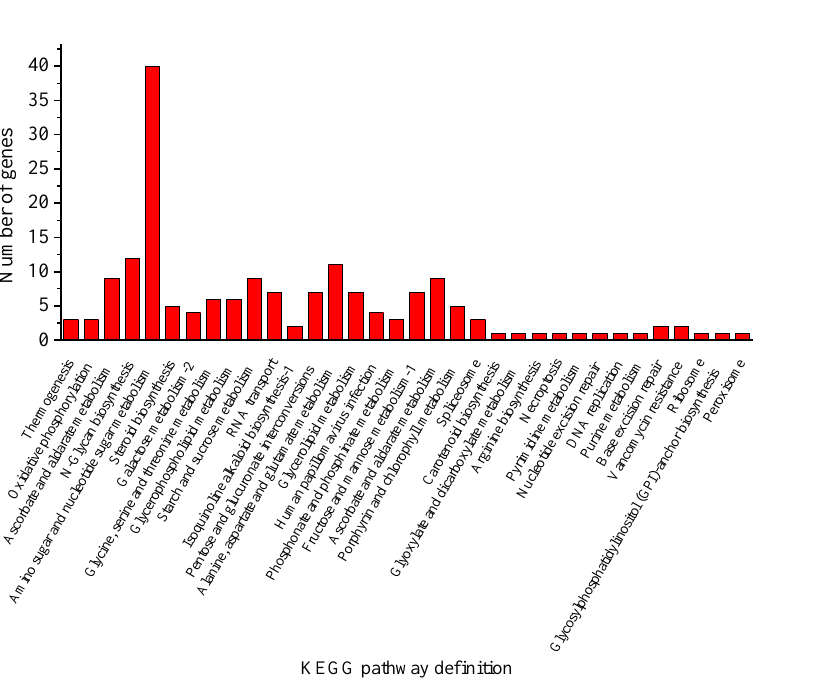
Figure 4. KEGG pathway classification of the unigenes involved in the development of cell wall. The X-axis presents specific pathways in the third hierarchy. Table 2. The genes involved in both the cellulose and mannose development pathways and their expression level of FPKM in H. pluvialis in this study.